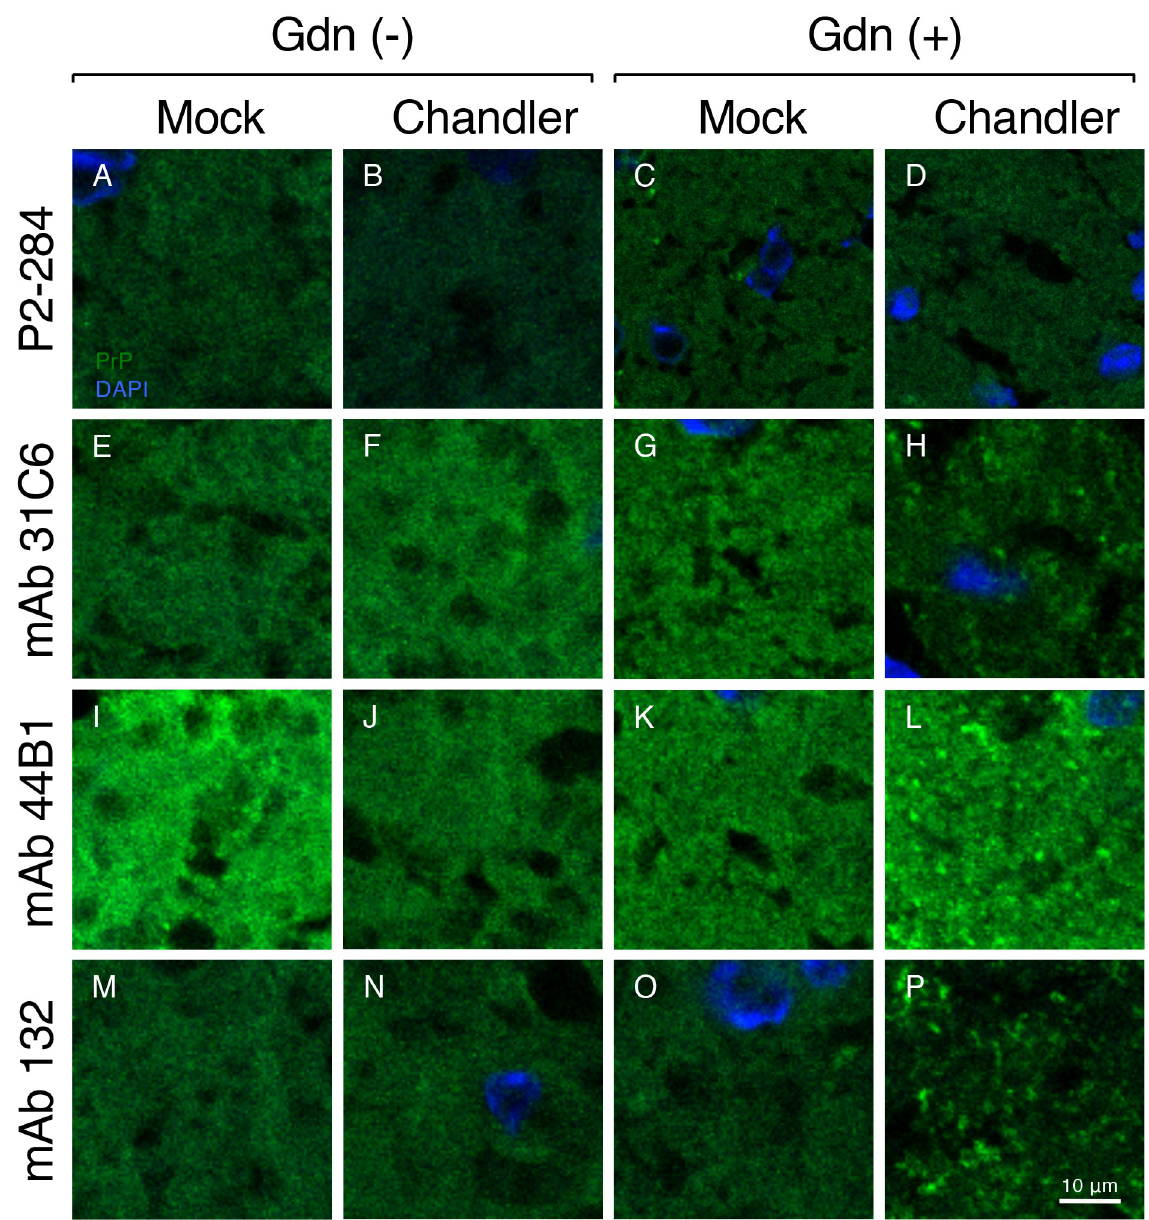
Fig 8. Detection of PrP Sc in frozen brain sections. IFA was performed using the frozen brain sections of Chandler strain-infected (Chandler) and mock-infected (Mock) mice at 120 dpi with (Gdn(+)) or without (Gdn(-)) 2.5 M GdnSCN pretreatment. PrP molecules (green) were stained with mAbs 31C6, 44B1, and 132 followed by Alexa Fluor 488 F(ab’) 2 fragment of goat anti-mouse IgG (H+L) (Invitrogen) as a secondary antibody. Anti-feline panleukopenia virus mAb P2-284 was used as a negative control mAb. Cell nuclei were counterstained with DAPI (blue). The fluorescent images were acquired from the coronal sections containing thalamus. Scale bar: 10 μ